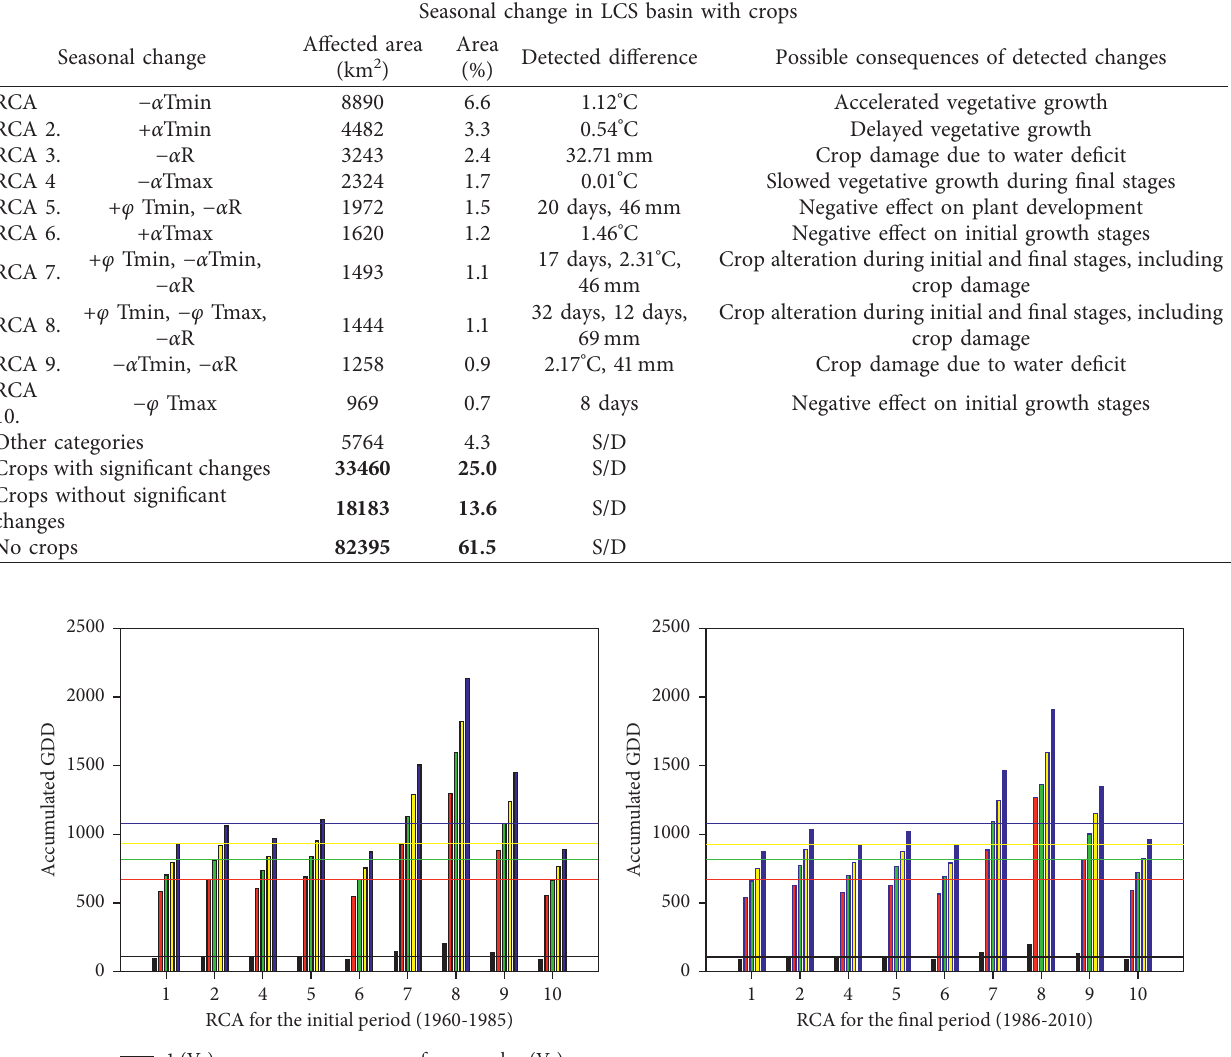
Table 2: Seasonal behavior for changes in R, Tmax, and Tmin in the basin and possible consequences for rainfed maize crops (1960–1985 to 1986–2010).